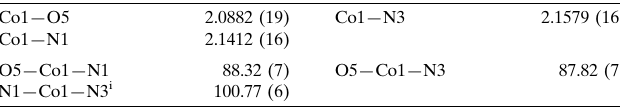
Hydrogen-bond geometry (A˚ , (cid:2) ).